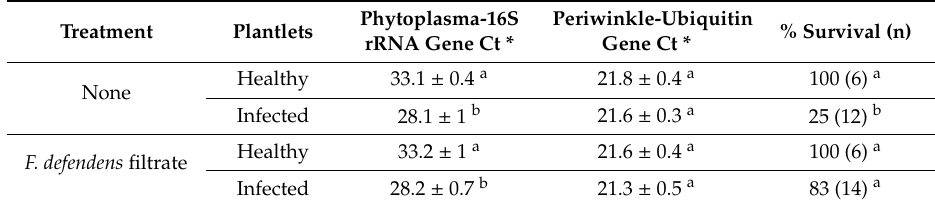
Table 1. The e ff ect of the F. defendens filtrate on the viability and phytoplasma titer (estimated by qPCR) of ex vitro periwinkle plantlets 20 days post